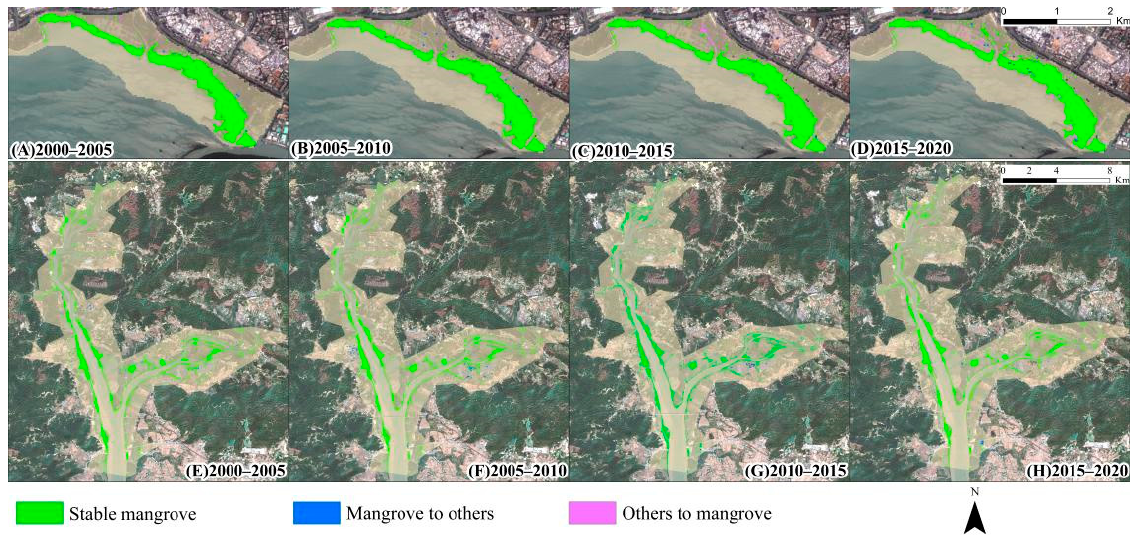
Figure A6. Mangrove gain and loss in FMNNR ( A – D ) and GTZMNWP ( E – H ) every five years from 2000 to 2020. ( A , E ): 2000–2005, ( B , F ): 2005–2010, ( C , G ): 2010–2015, ( D , H ): 2015–2020.